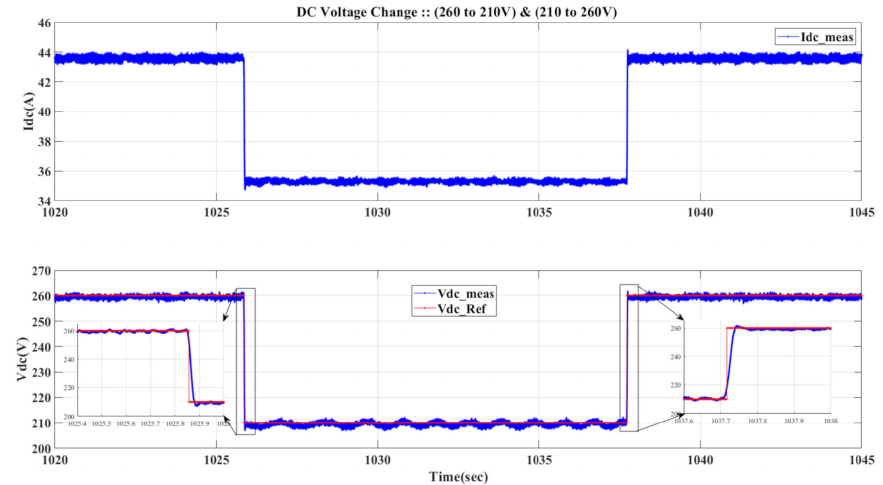
Figure 17. Test 1: DC voltage reference tracking.